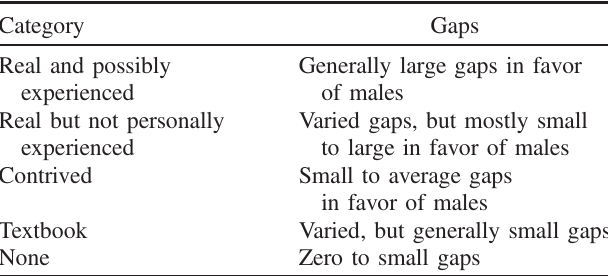
TABLE VI. Pattern of gender gaps within the content